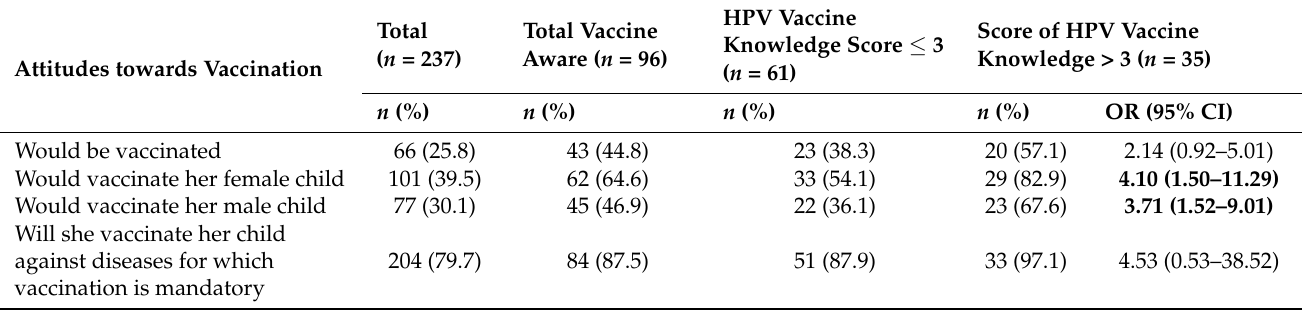
Table 4. Attitudes towards vaccination.